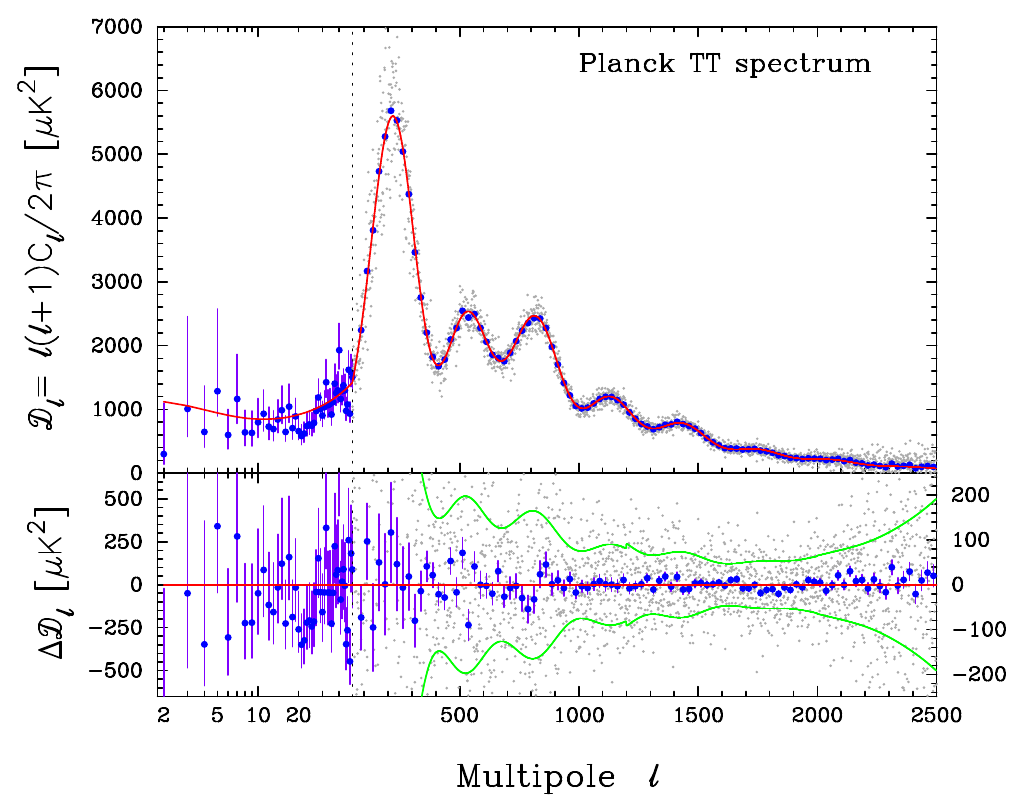
Figure 8: Diagram of the CMB anisotropies, plotted as strength against spatial frequency, from the 2013 Planck data. The measured points are shown together with best-fit models. Note the acoustic peaks, the largest of which corresponds to an angular scale of about half a degree. Image reproduced with permission from [2], copyright by